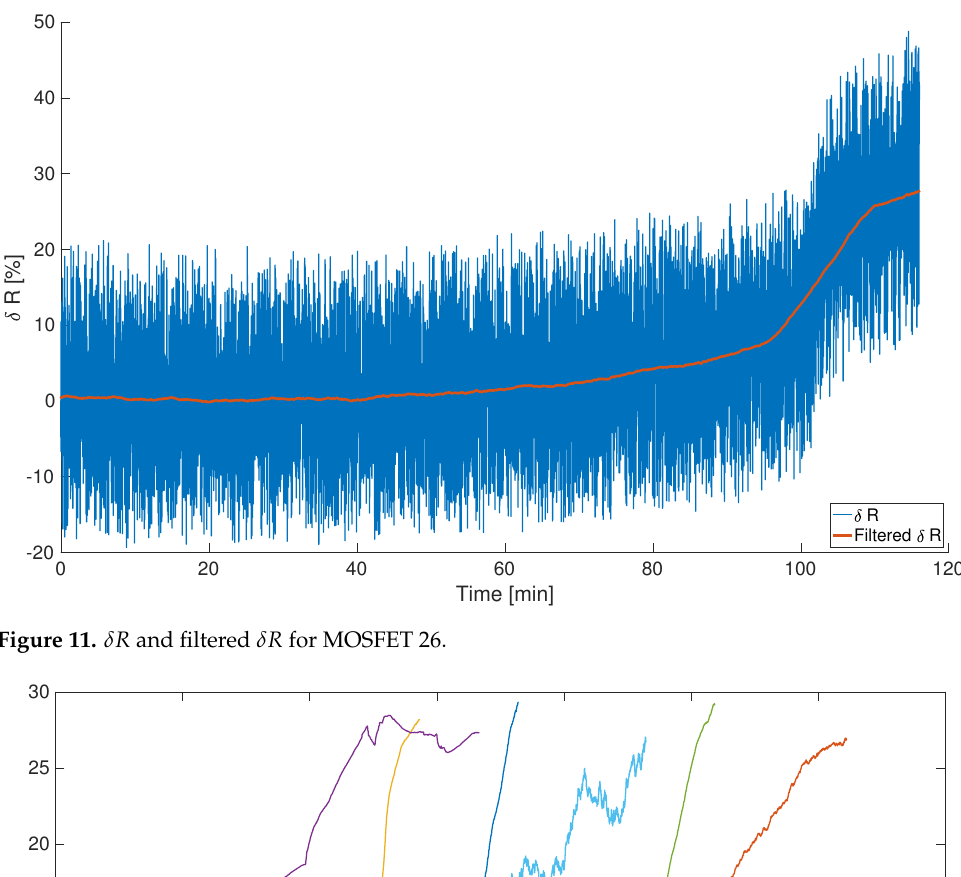
Figure 11. δ R and filtered δ R for MOSFET 26.